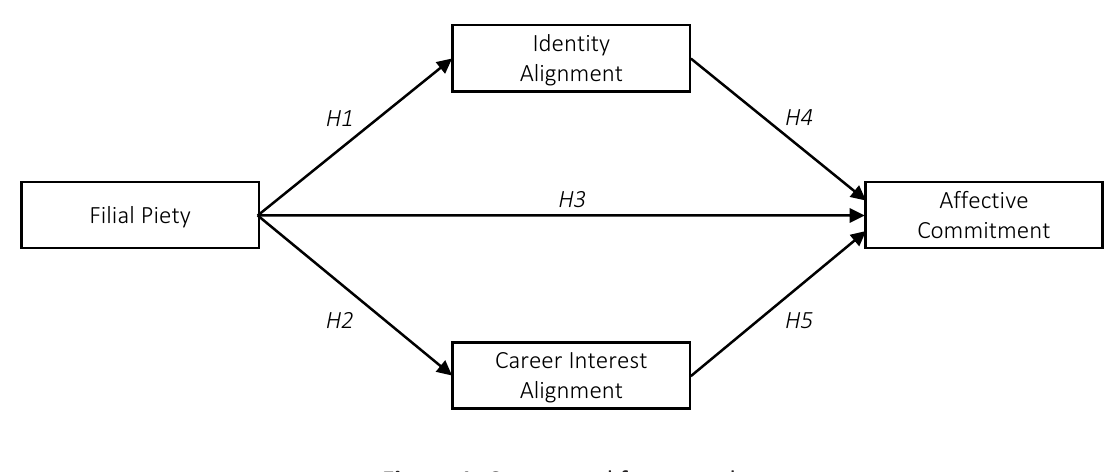
Figure 1. Conceptual framework